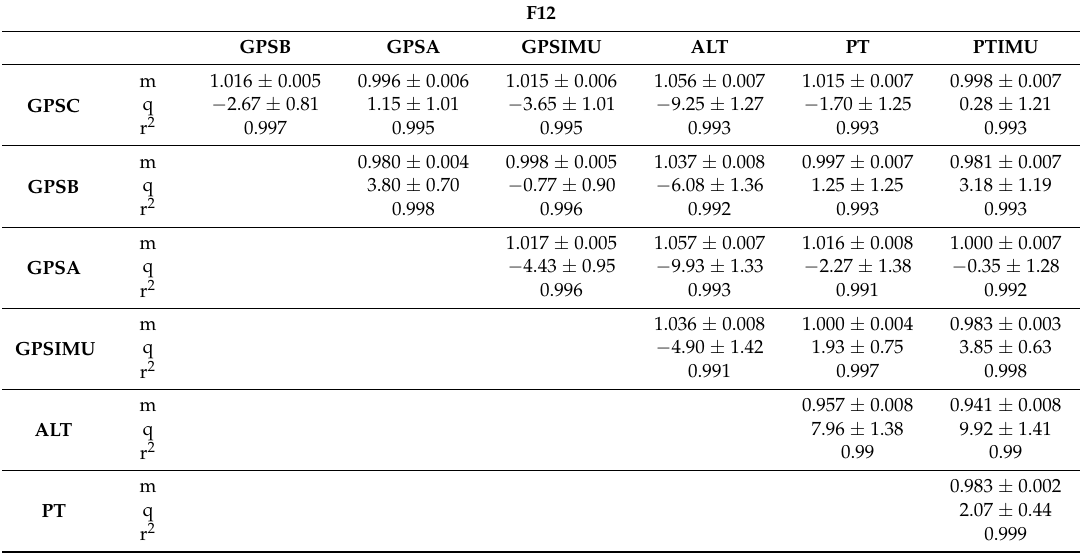
Table A2. Linear regression data of F12 (DATASET 2 α